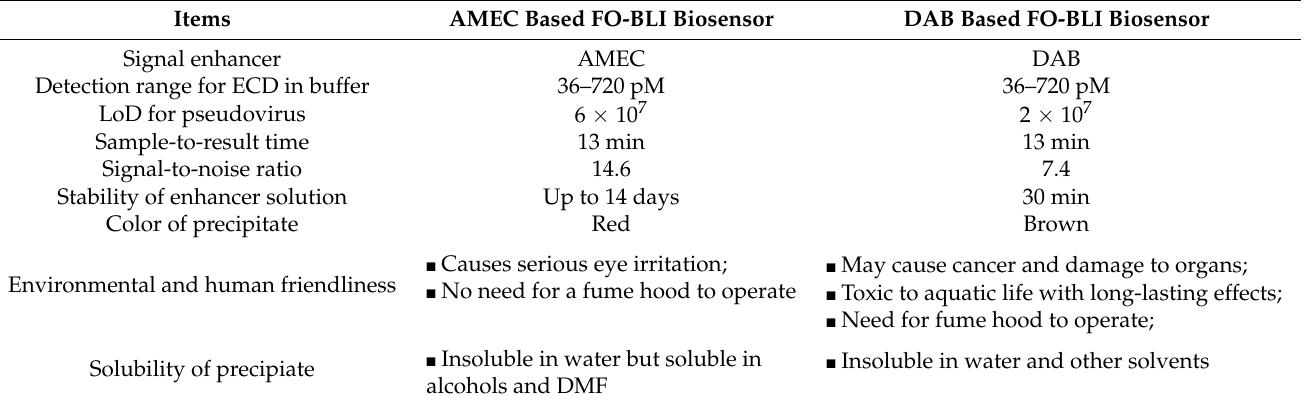
Figure 2. ( A ) Evaluation of the dilution factor of the precipitating agent AMEC on ECD detecting. ( B , C ) Nonlinear binding curve of ECD detection (36–720 pM) in high-salt SD buffer using DAB and AMEC, respectively. ( D ) Measurements of six concentrations of pseudovirus based on DAB-based FO-BLI and AMEC-based FO-BLI, respectively. Table 1. Comparison of AMEC and DAB-based FO-BLI biosensors for SARS-CoV-2 detection.